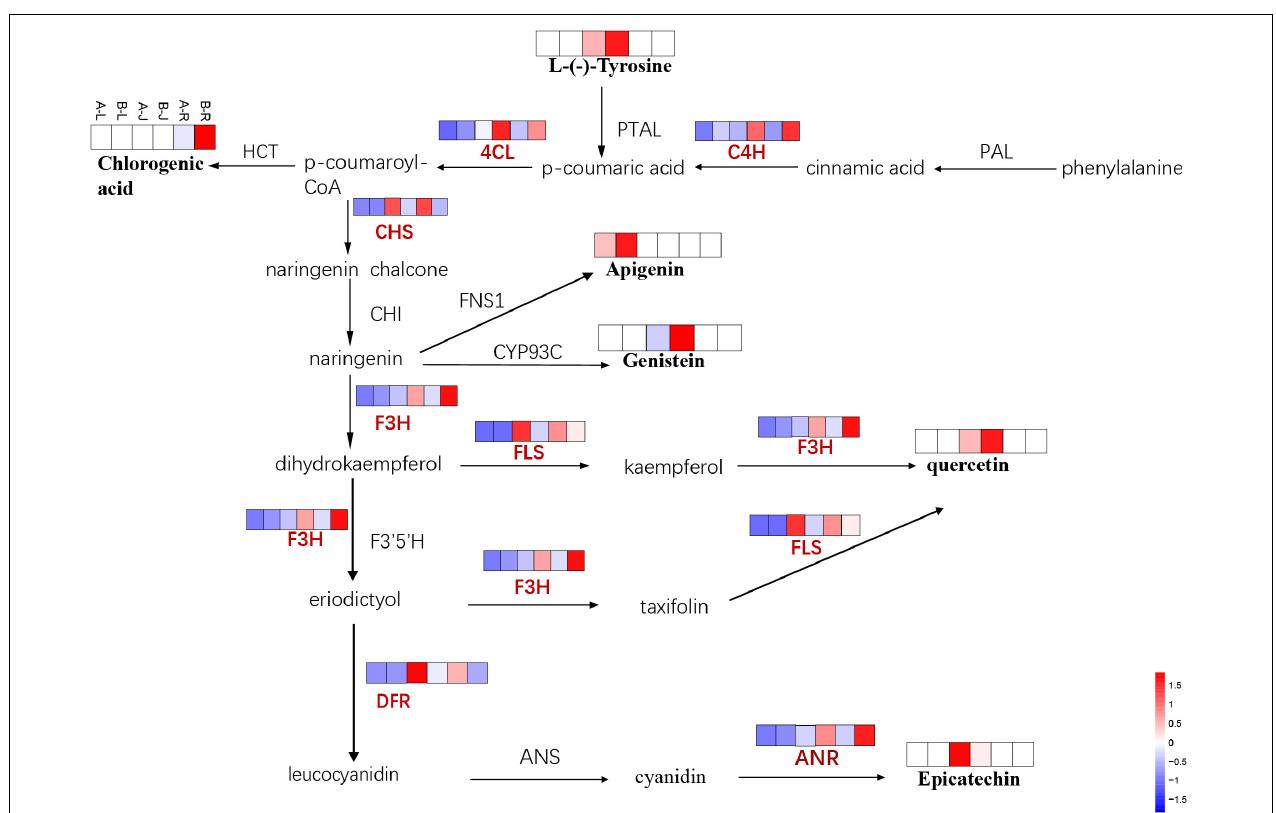
FIGURE 11 | The DEGs and DAMs involved in flavonoid biosynthesis in response to inflorescence